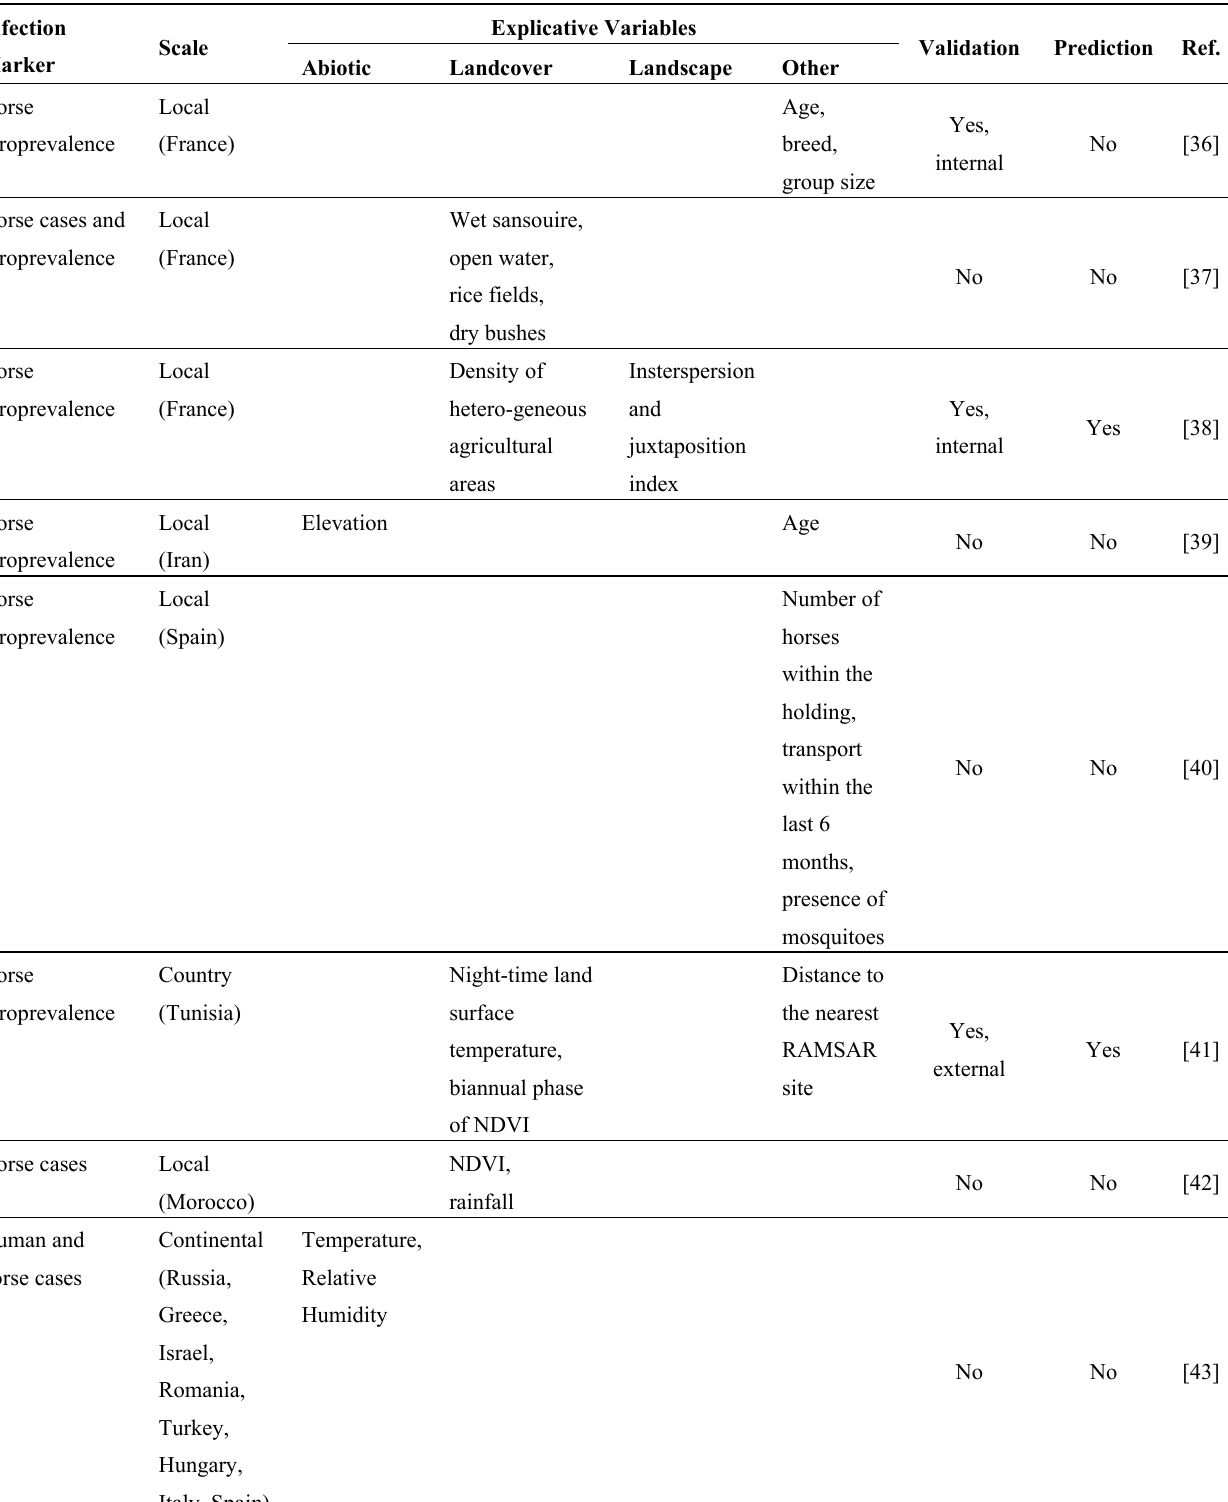
Table 1. List of articles aiming at identifying the risk factors of WNF occurrence and/or transmission, and variables associated with seroprevalence or case occurrence in human or horses. Ref. stands for